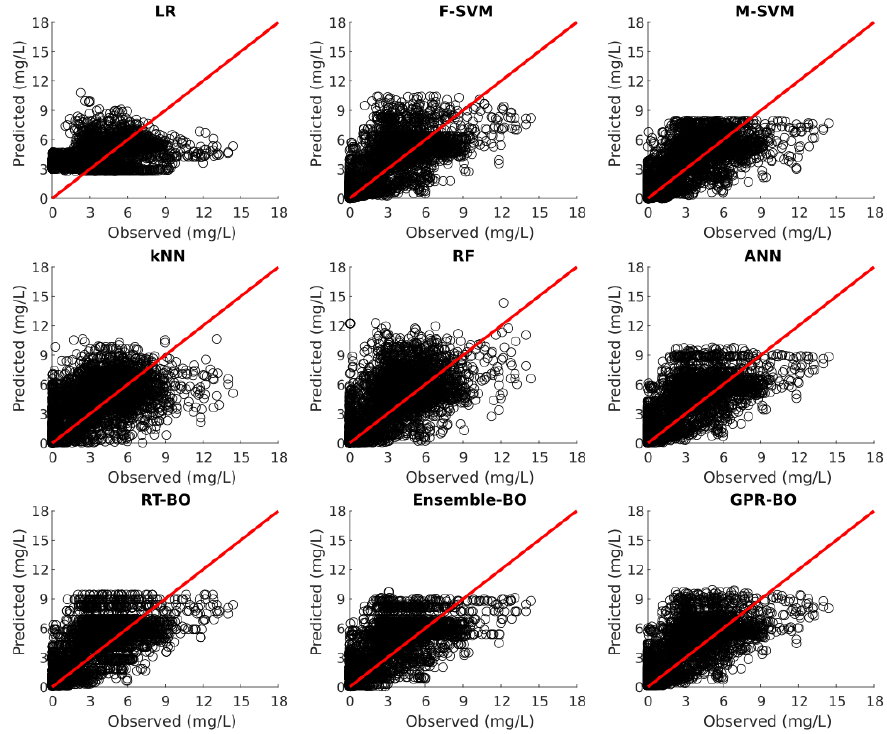
Figure 4. Observed versus predicted daily nitrate concentration for Maumee using different ML algorithms.